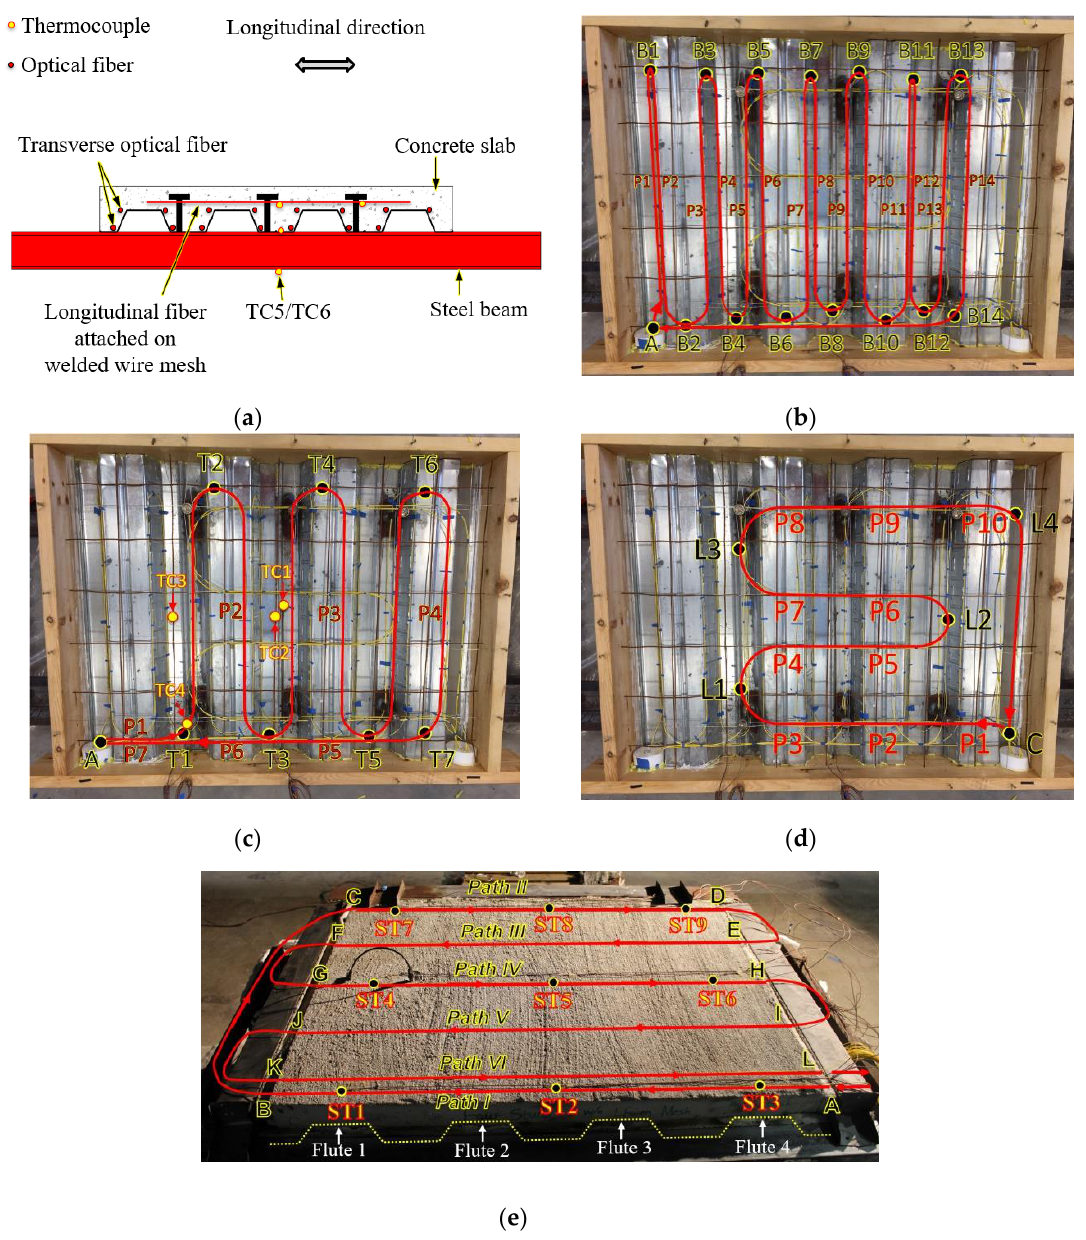
Figure 3. Instrumentation layout: ( a ) elevation view, ( b ) top view of DFOS-1, ( c ) top view of DFOS-2, ( d ) top view of DFOS-3, and ( e ) top view of DFOS-4.